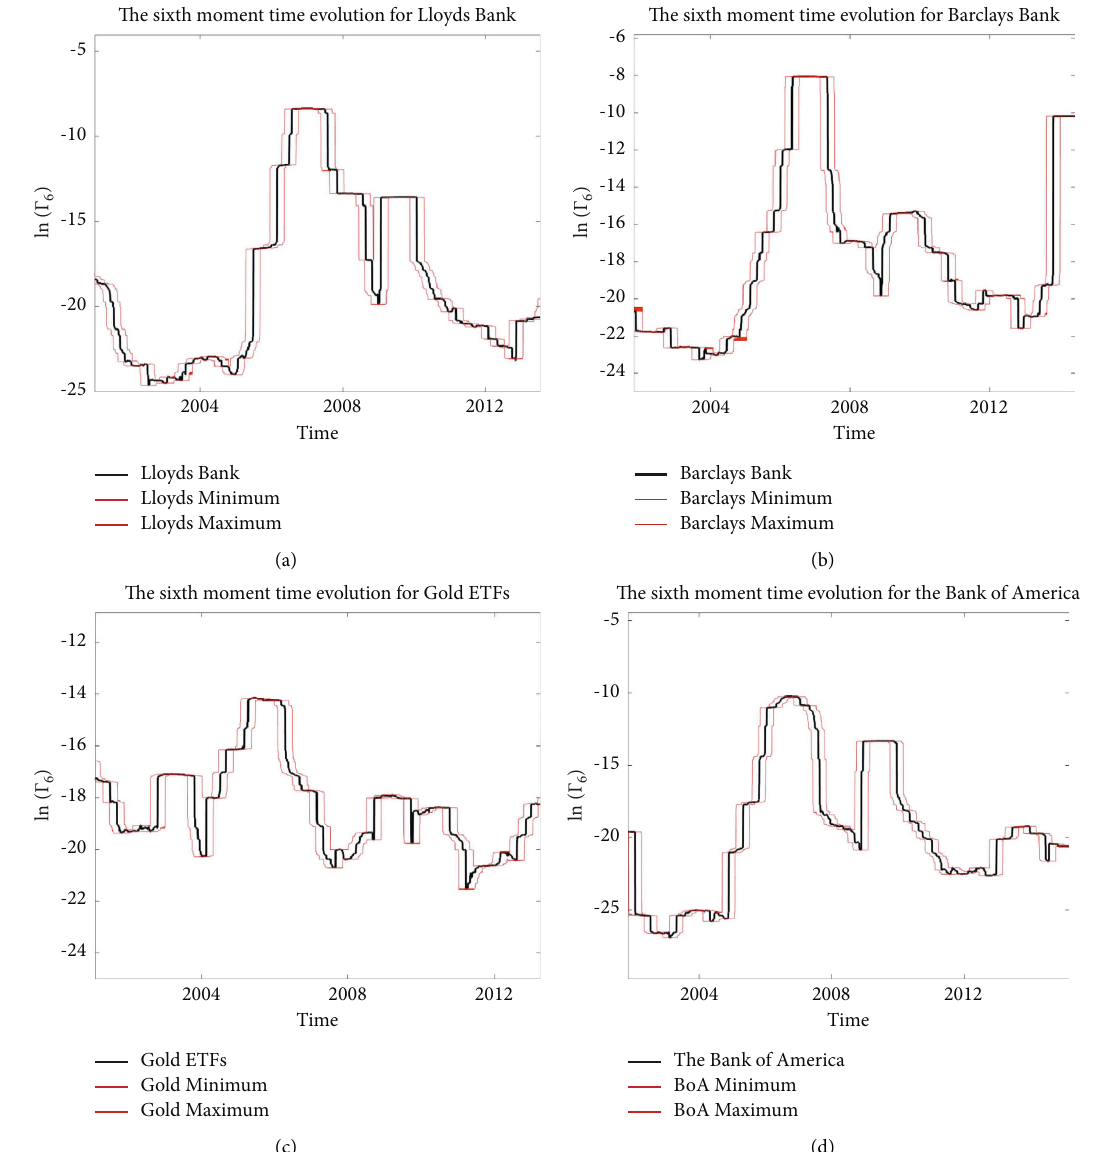
Figure 1: The behaviour of the logarithm of the sixth-order moment for six-month long intervals from 2000 to 2018, complete with the error intervals, shown by the solid red lines for each security, for details see A. During the crisis period, 2007–2009, we see a spike in the value of the raw moment for all securities apart from gold. Before and after the financial crisis we see small fluctuations in the value of the sixth-order moment over time. (a) Lloyds Bank, (b) Barclays Bank, (c) Gold, and (d) the Bank of